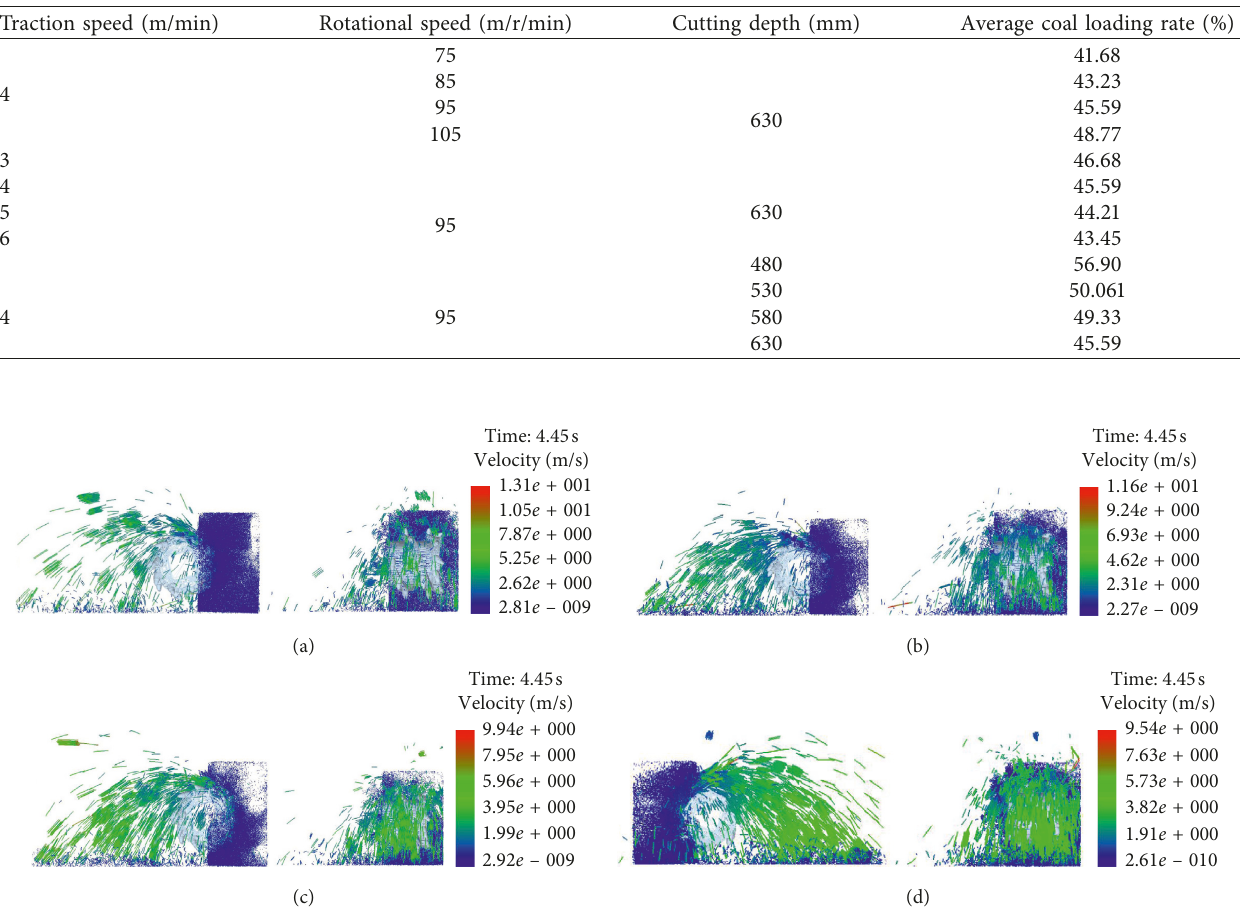
Table 7: The statistics of the coal loading rate.